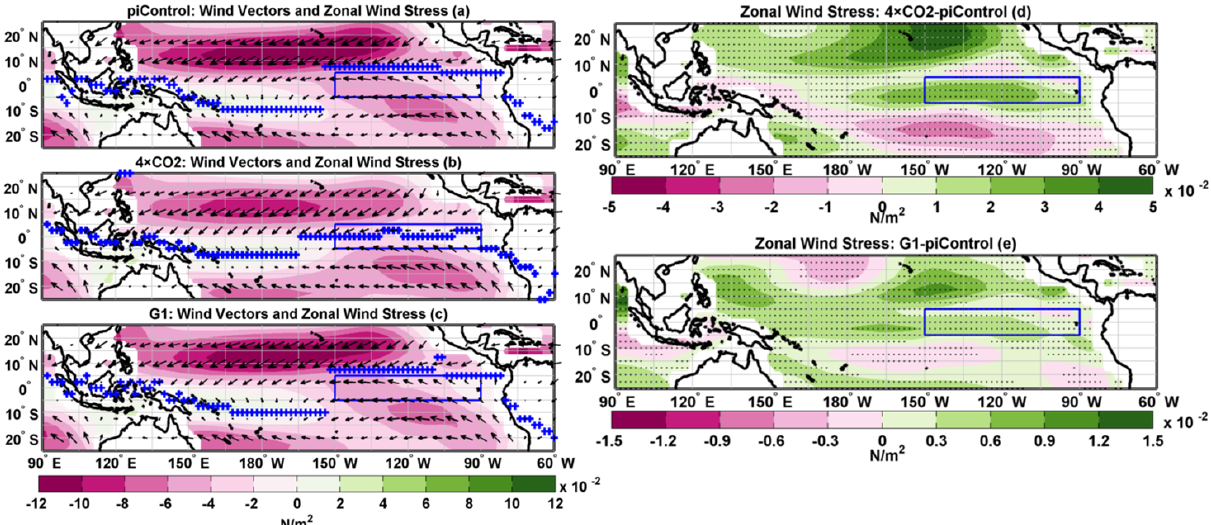
Figure 3. Tropical Pacific zonal wind stress mean DJF climatology: (a) piControl, (b) 4 × CO 2 , (c) G1, (d) 4 × CO 2 − piControl difference, and (e) G1 − piControl difference. Black arrows indicate the direction of 10m wind. The blue plus sign in (a) – (c) indicates latitudes with maximum rainfall. Stipples indicate grid points where the difference is statistically significant at 99%cl using a non-parametric Wilcoxon rank-sum